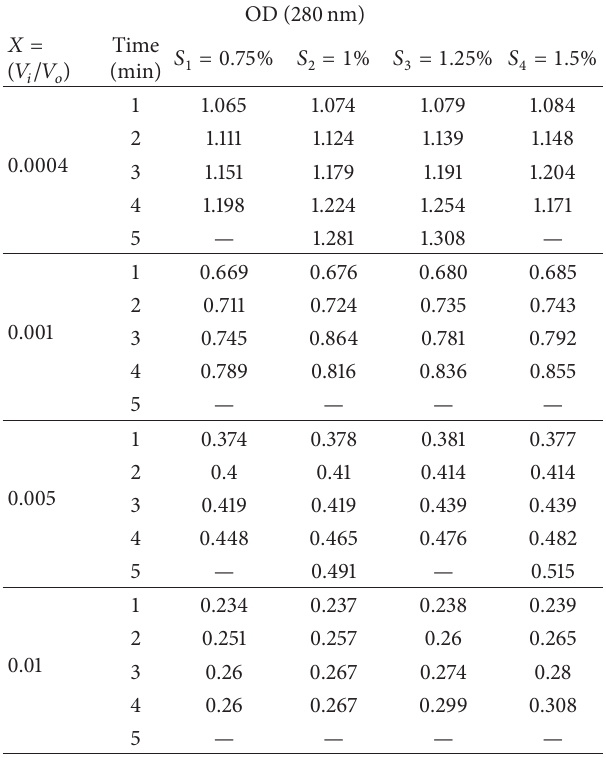
Table 3: The absorbance of the samples with different DFP inhibitor